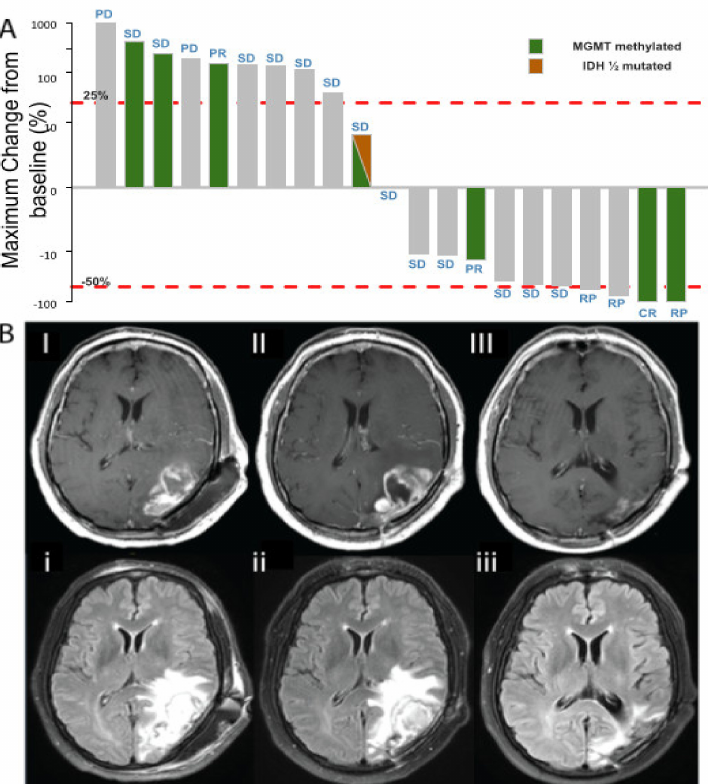
Figure 3. ( A ) Waterfall plot of MRI evaluation according to RANO criteria. Percentage change in tu- mor size at maximum reduction from baseline. Thirty-six patients were evaluable for tumor response. Red lines indicate the RANO cutoff for progressive disease (+25%) and PR ( − 50%). Note: one patient experienced a pseudo-progression on the first evaluation, while in the concomitant phase, having an increase of >100%. One month after the patient experienced a partial response (tumor shrinkage of 50% that lasted one month) and afterwards the patient remained stable. ( B ) Radiological evaluation of one patient in the dose escalation phase, at 250 mg/d dose level: 56-year-old male, partial resection in May 2016 (GBM, MGMT methylated). I. May 2016, post-operative MRI (I: Gd enhanced T1, i: